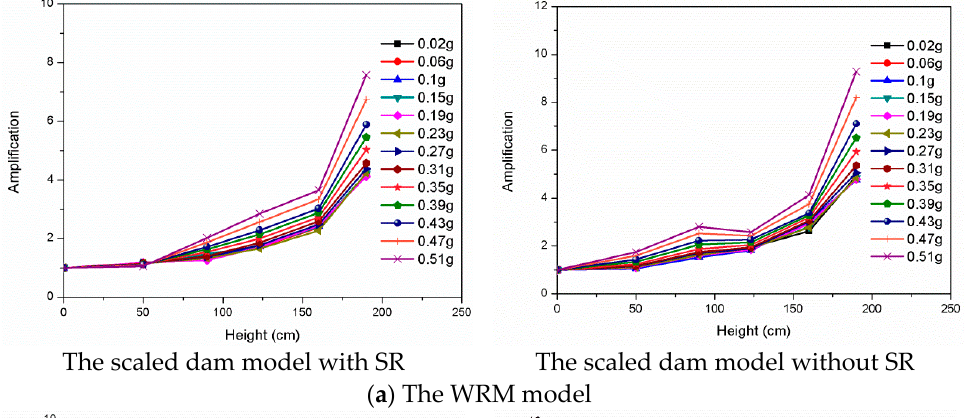
Figure 5. The variation of acceleration amplification factor with height.